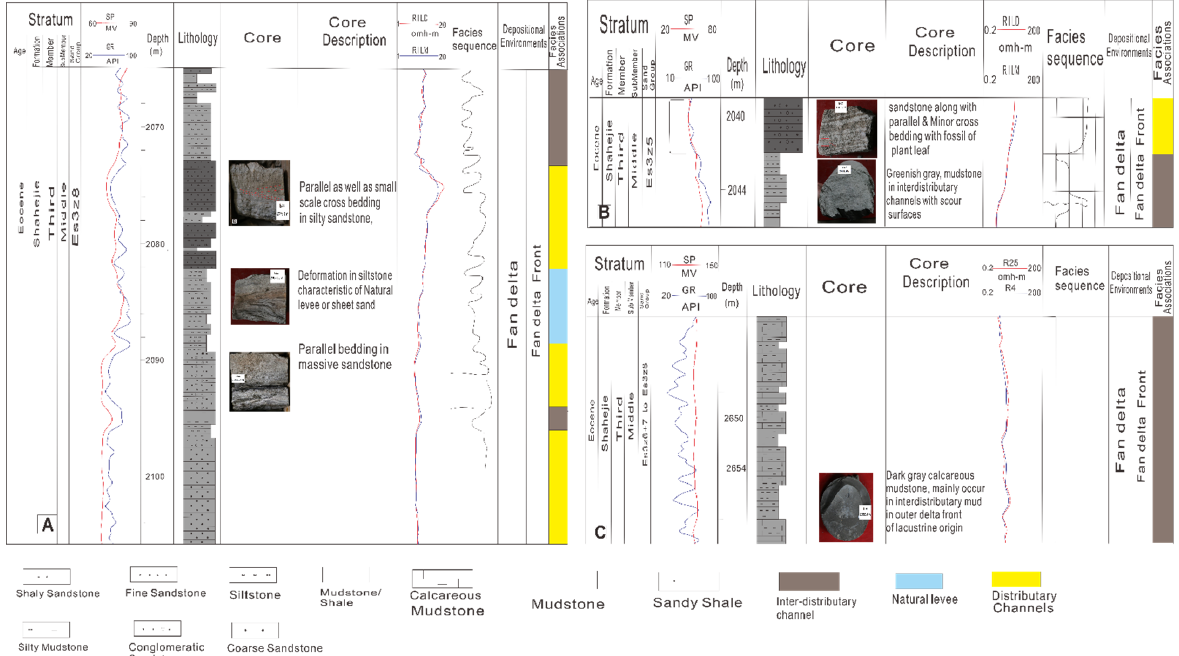
Figure 5. ( A – C ) Core wells k44, k47 and l-9 in the study area, representing trend of log suits with lithology, core and sedimentary facies. Cores of those dispatched in (Table 1). As described above, siltstones are associated with sandstones that are described in Figure 5, in which lower GR values of Box shaped with parallel as well as small scaled cross bedding in silty sandstone (PCSs) are interpreted at the depth of 2070.1 m in well k44 (Figure 5A). It is considered to be formed in distributary channel deposits, the thick- ness of which varies up to 4 m (Figure 5A). It marks a sharp contact with facies associa- tions of interdistributary channels, and displays a fining upward trend on the top (Figure 5A). Deformation in siltstone (DS) is also found in natural levee deposits with rusted color at 2087.9 m in well k44 where siltstone is inversely graded into sandstone on the top. On the basal side, parallel bedding in massive sandstone (MS) is interpreted in channel de- posits at the depth of 2088.75 m that shows the box shaped curve on GR log (Figure 5A).